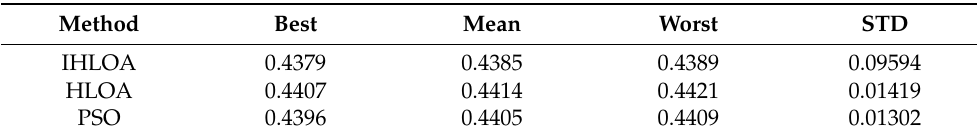
Table 2. Statistical Analysis of algorithms performance for allocation of PVs in deterministic approach in 69 ‐ bus system.